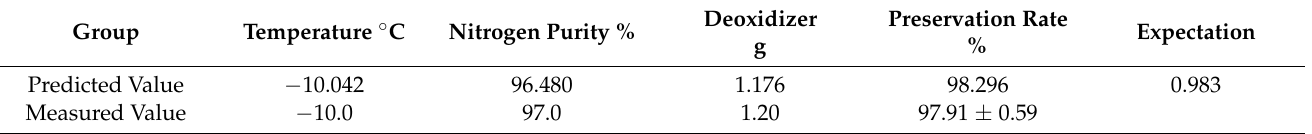
Table 4. Predicted value and measured